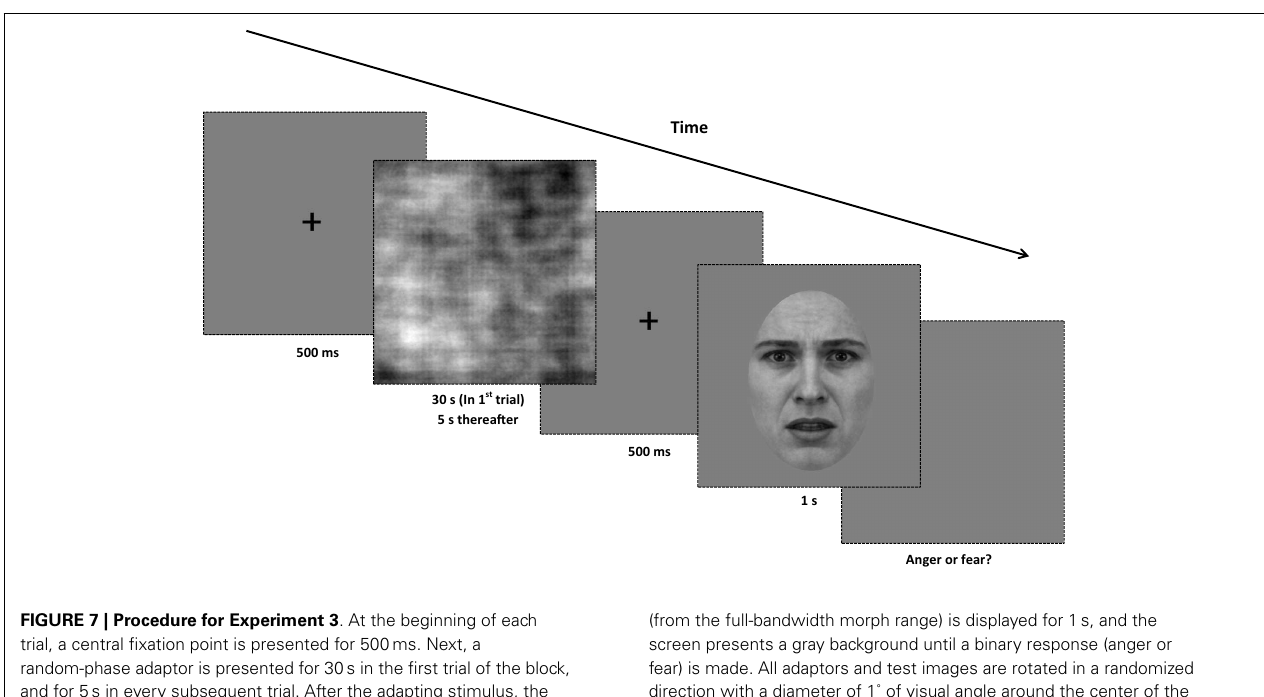
FIGURE 7 | Procedure for Experiment 3 . At the beginning of each trial, a central fixation point is presented for 500ms. Next, a random-phase adaptor is presented for 30s in the first trial of the block, and for 5s in every subsequent trial. After the adapting stimulus, the central fixation point is displayed for another 500ms.The test image